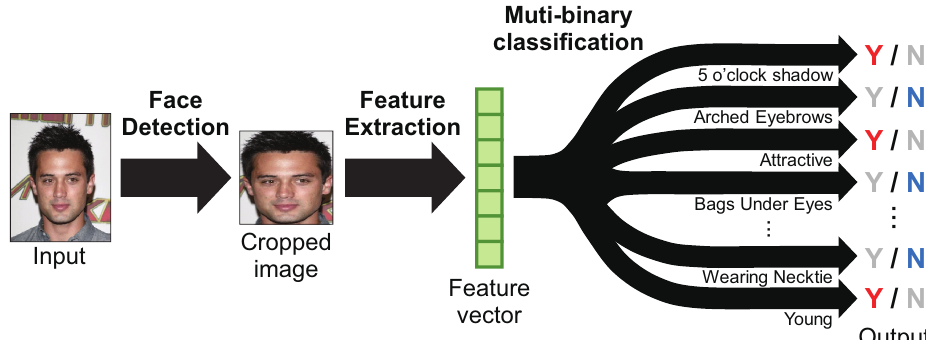
Figure 1. A typical processing flow of face attribute estimation. Face attribute estimation consists of multiple two-class classification problems. First, a face region is detected from a face image, and features are extracted. Then, the features are input to a discriminator for each attribute, and the presence or absence of the attribute is